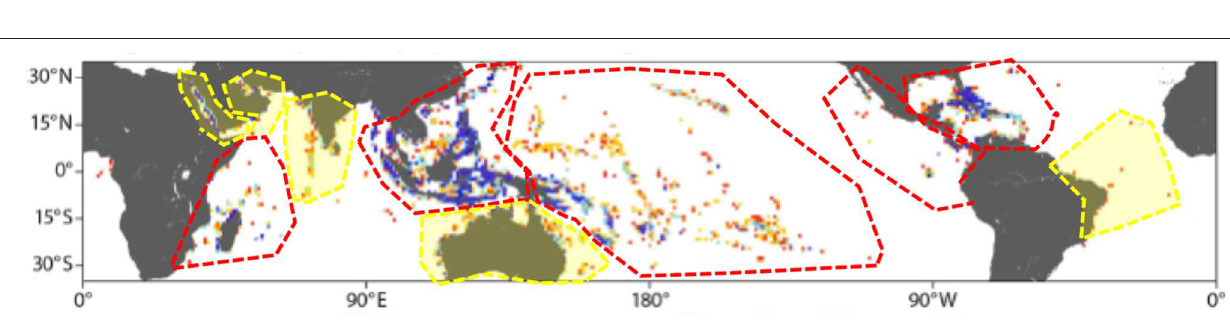
FIGURE 2 | GCRMN regions illustrated with approximate boundaries. Regions with red shading have completed or in advanced stages of reporting by the end of 2018 (Caribbean, Western Indian Ocean, Pacific, East Asian seas, and the Eastern Tropical Pacific). Regions in yellow, reporting during